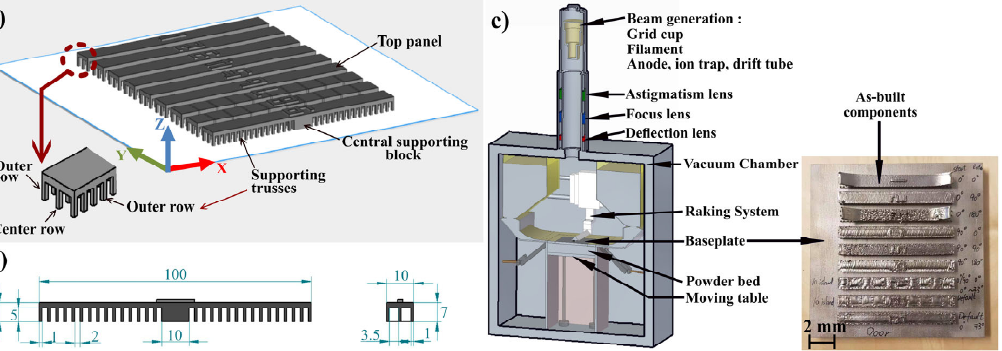
Figure 2. ( a ) Printing layout, ( b ) size and ( c ) the Arcam EBM system used for this study and visual condition of the deflection testing parts after